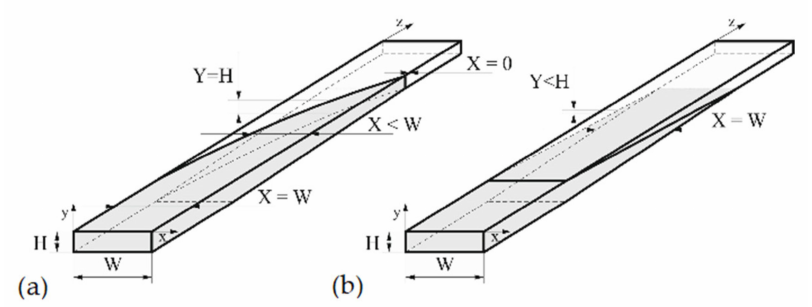
Figure 1. Melting mechanism: ( a ) Two-dimensional model (Tadmor model), ( b ) one-dimensional model: W—screw channel width, X—solid bed width, H—screw channel height, Y—solid bed